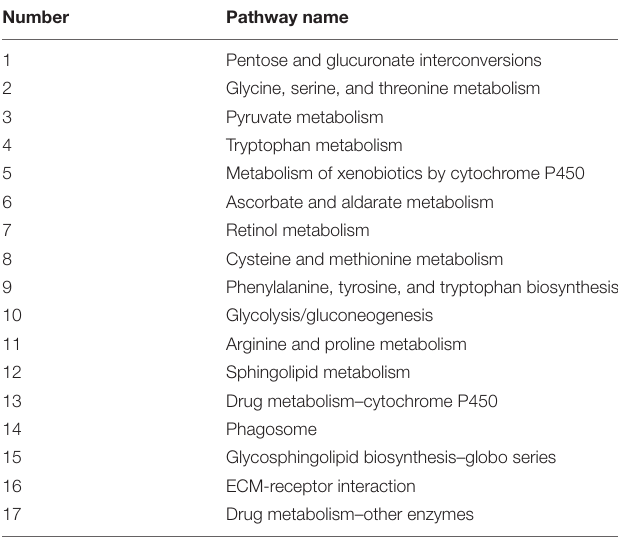
TABLE 2 | Immune-related KEGG pathways enriched in Bactrocera dorsalis adults.